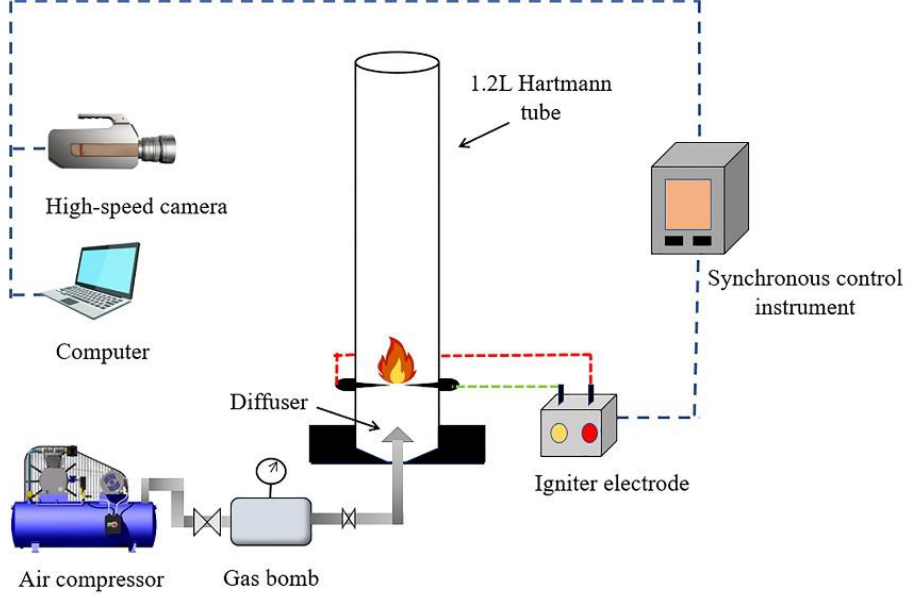
Figure 1. Schematic diagram of experimental apparatus.